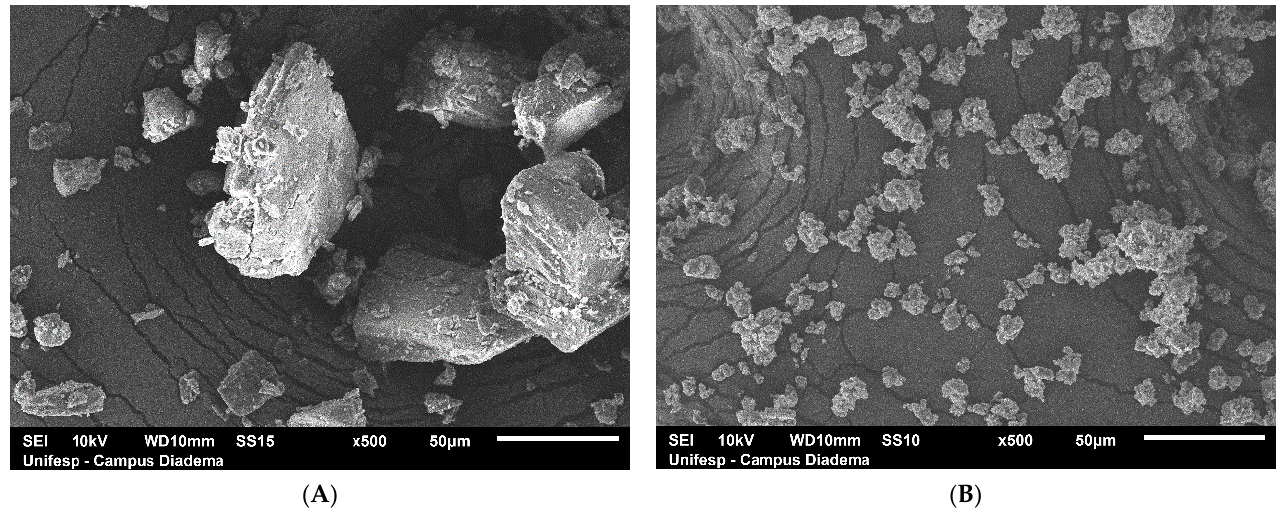
Figure 3. Scanning electron microscopy (SEM) images of ( A ) β -cyclodextrin ( β -CD), ( B ) Co-evaporation.